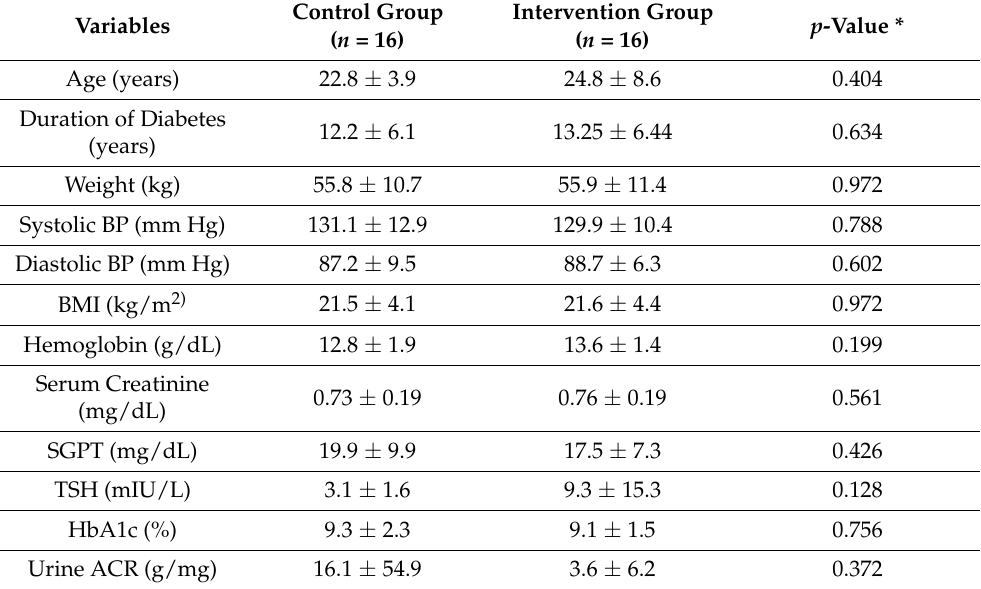
Table 1. Baseline characteristics of the participants in the control and intervention groups. Control Group Intervention Group p -Value * Variables ( n = 16) ( n = 16) Age (years) 22.8 ±